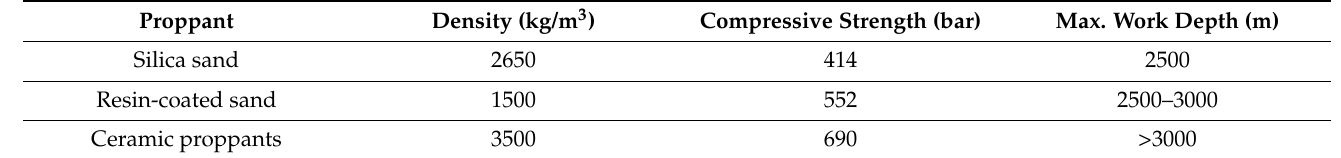
Table 13. Proppant’s